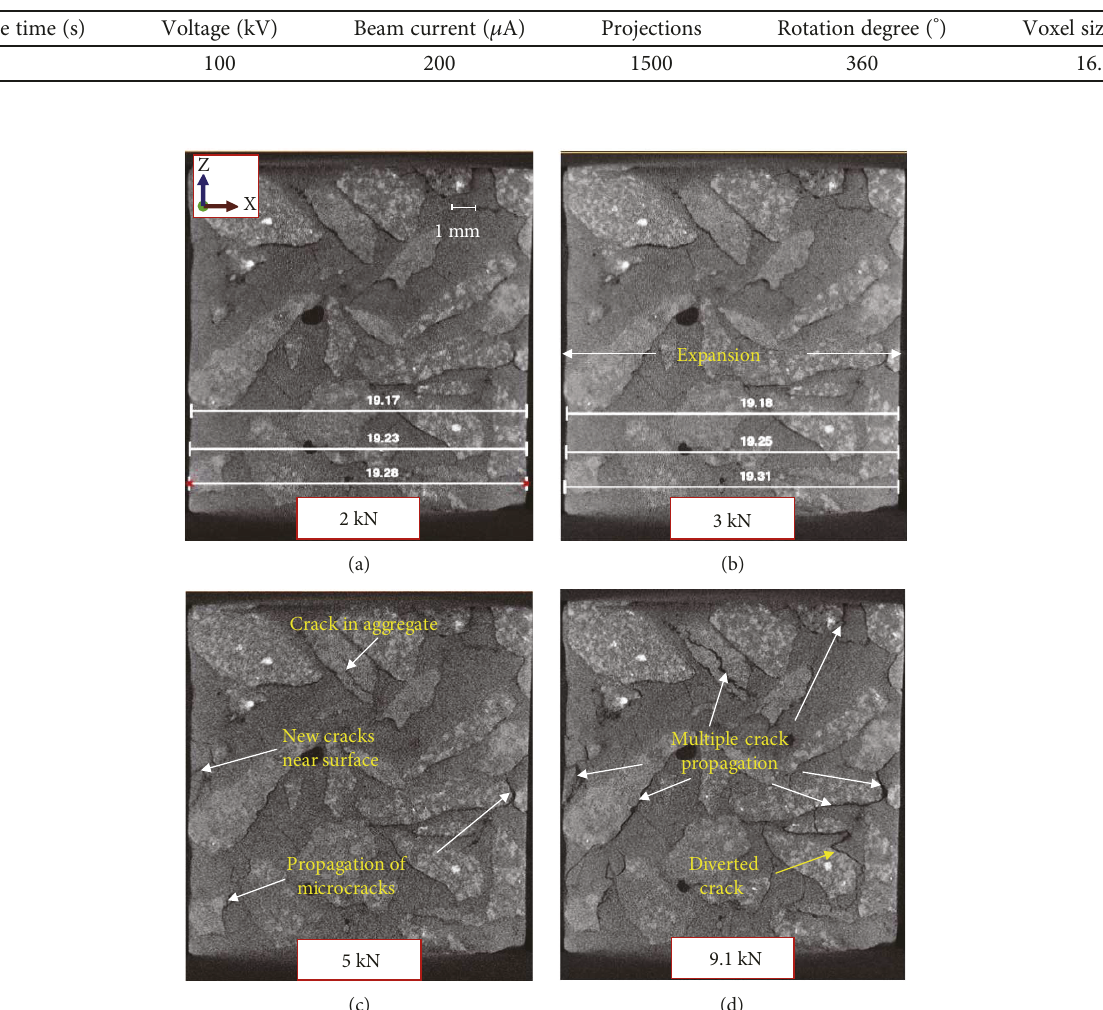
Figure 1: The in situ XCT facility with DEBEN loading system and the sample before loading. Table 1: XCT imaging parameters.